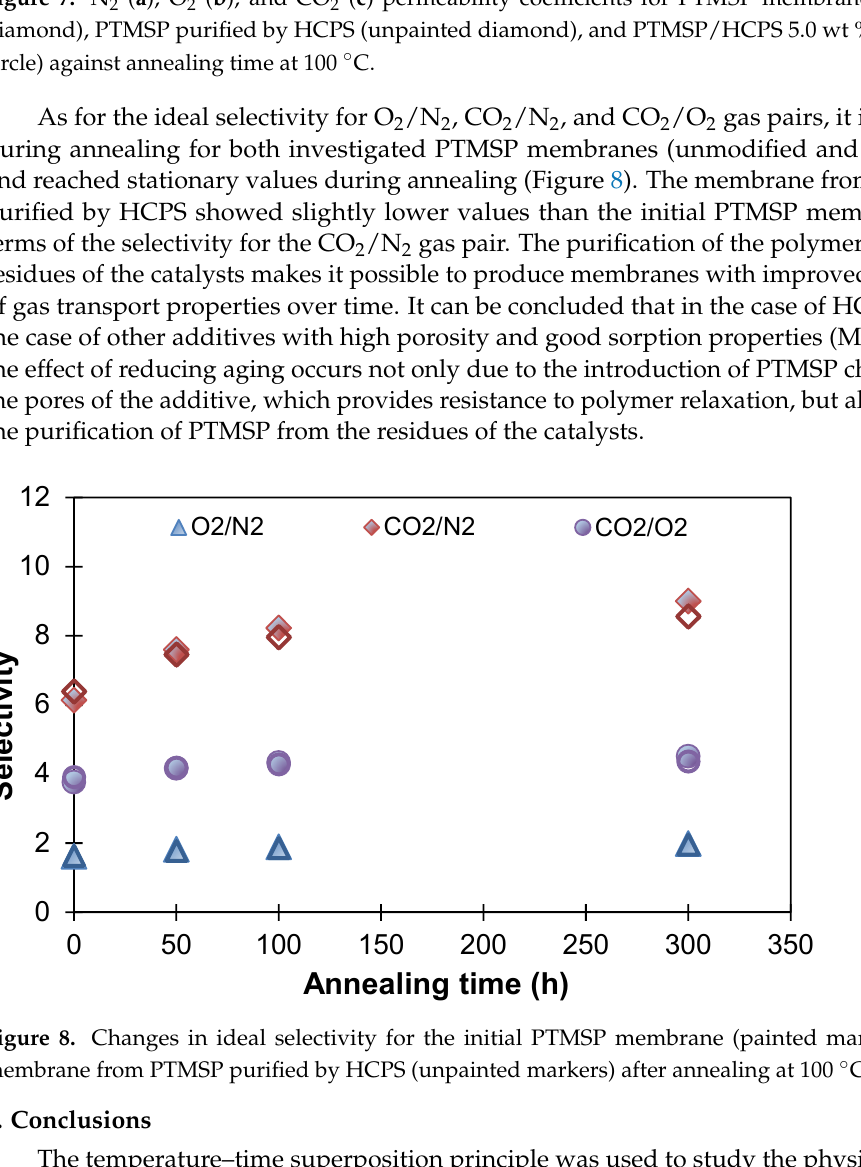
Figure 8. Changes in ideal selectivity for the initial PTMSP membrane (painted markers) and membrane from PTMSP purified by HCPS (unpainted markers) after annealing at 100 °C for 300 h.